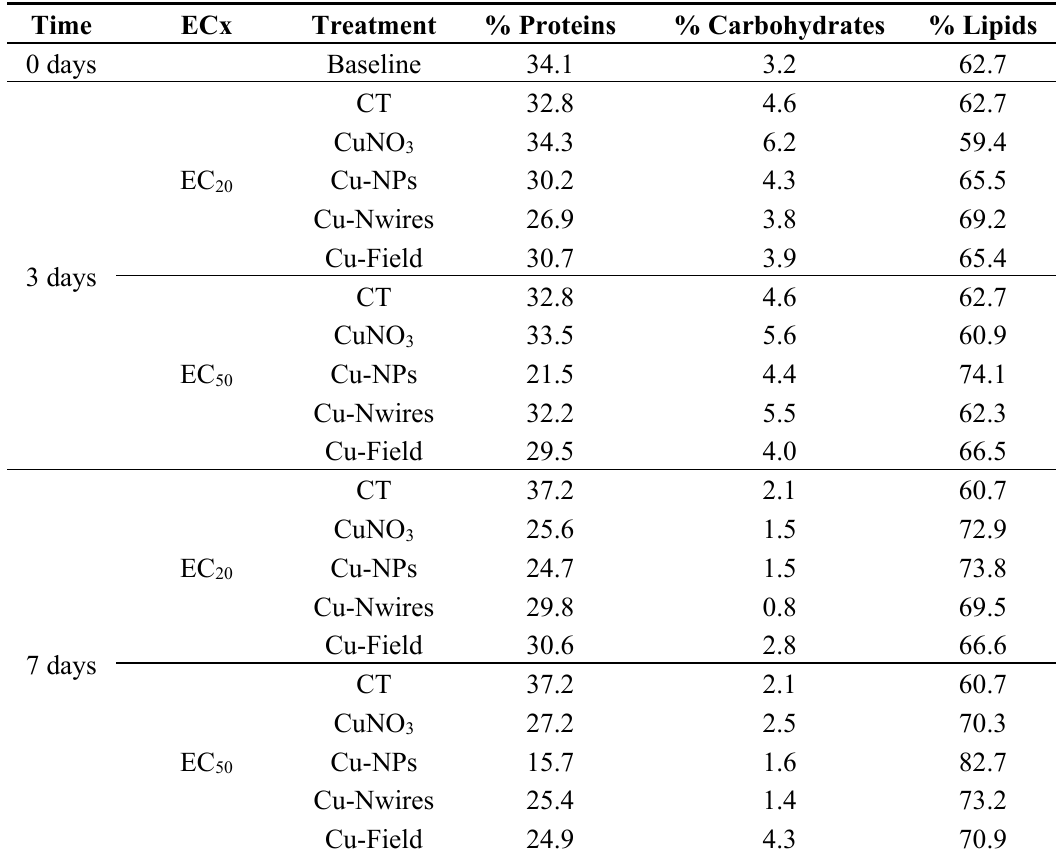
Table A1. Proportion (%) of energy reserves available (proteins, carbohydrates and lipids) in Enchytraeus crypticus after exposure to the concentrations of effect on reproduction EC 20 and EC 50 of copper nitrate (CuNO 3 ), copper nanoparticles (Cu-NPs), copper nano-wires (Cu-Nwires) and copper-salt from field contamination (Cu-Field), for 0 days (Baseline), 3 and 7 days. CT: